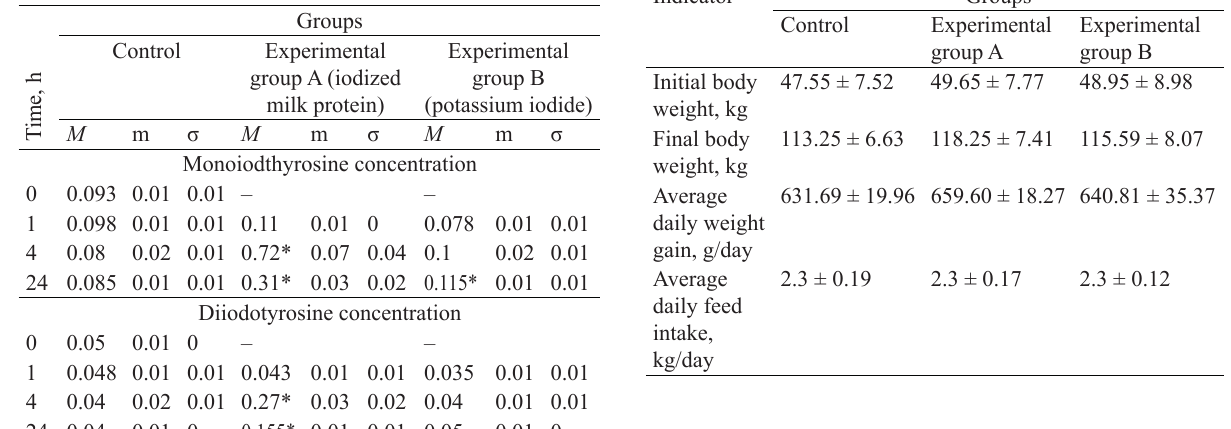
Table 3 Iodotyrosine concentration in rat blood plasma, ng/mL (n = 4)